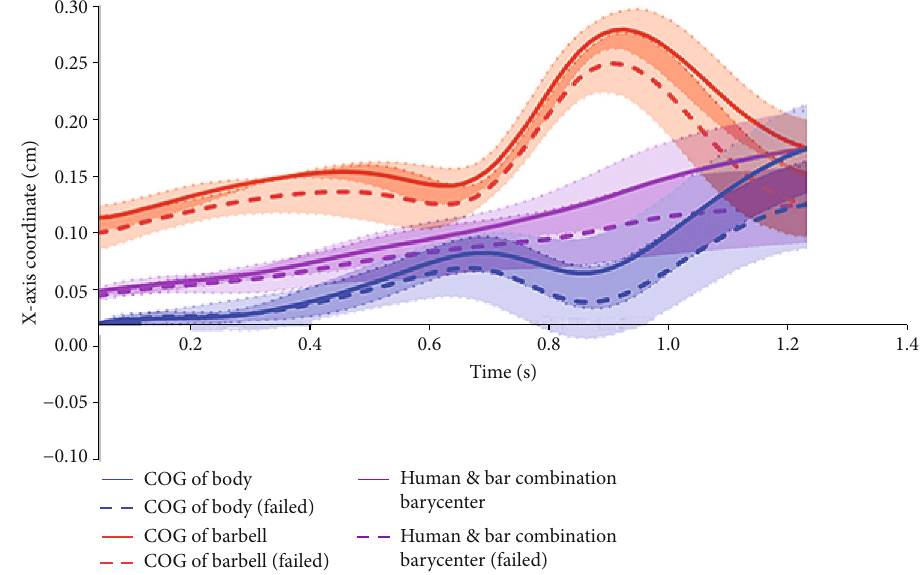
Figure 7: Successful and unsuccessful trajectories of the COG of barbell and body and human and bar combination barycenter on the X -